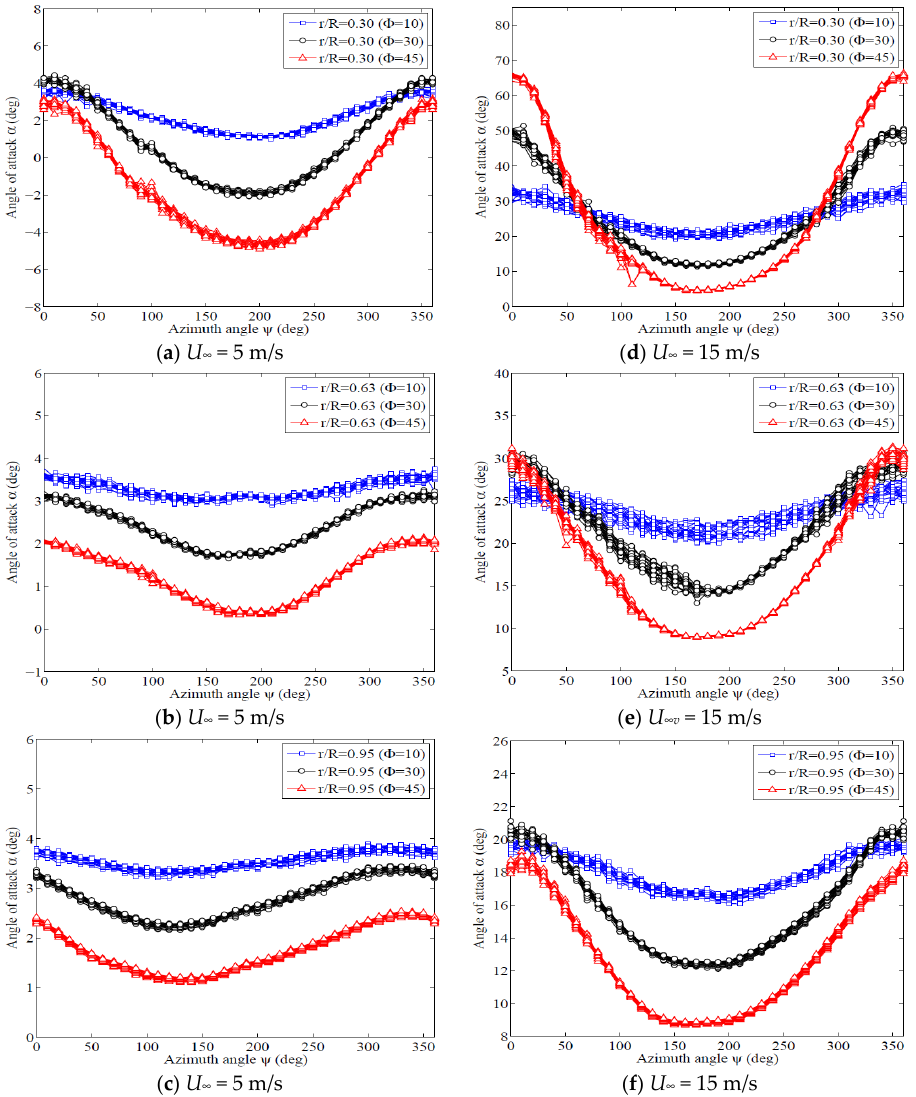
Figure 4. Variation of the unsteady angle of attack with the blade azimuth angle at different radial locations and yaw angles at wind speeds of 5 and 15 m/s.